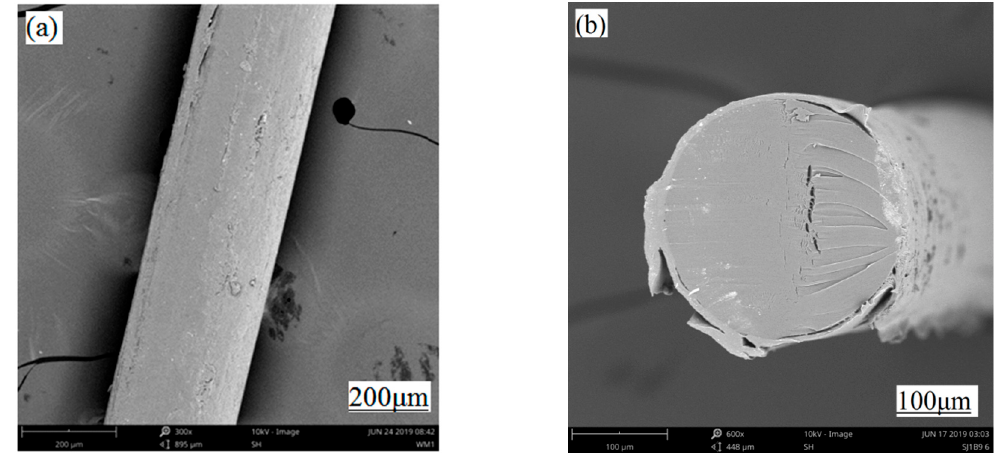
Figure 9. SEM image of the surface and cross-sectional views of side-emitting polymer optical fiber prepared under optimal conditions ( a ) Radial image ( b ) Cross-sectional image.